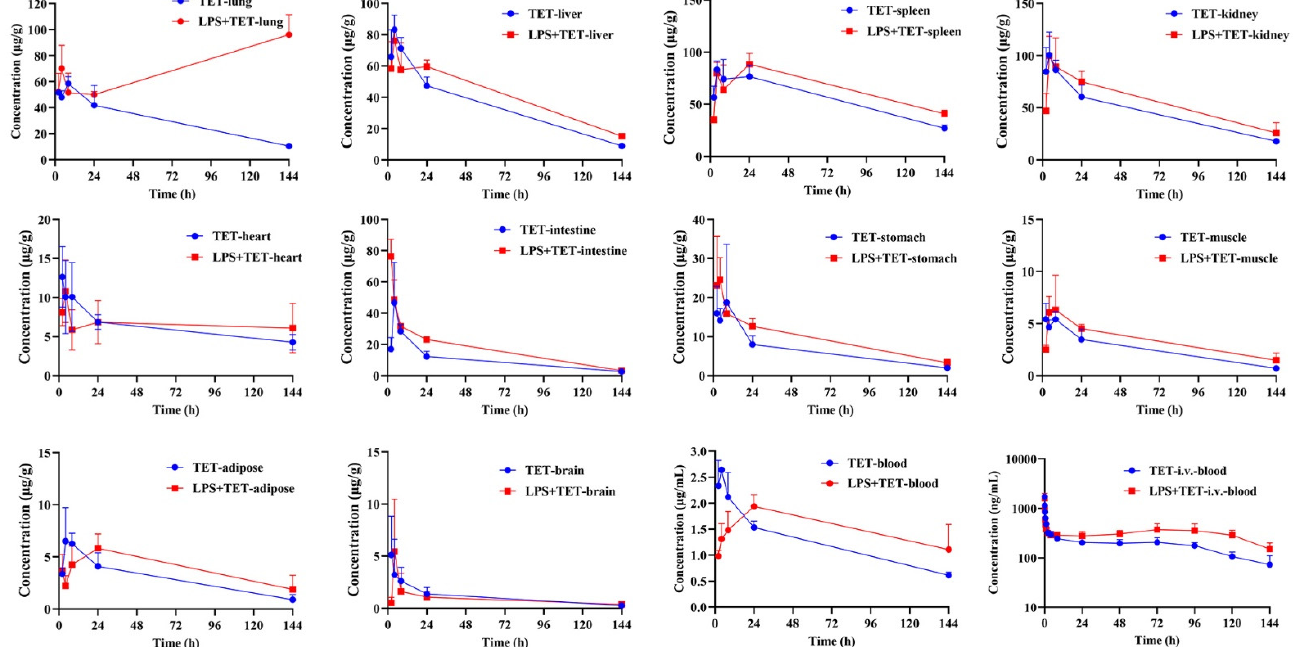
Int. J. Mol. Sci. 2022 , 23 , x FOR PEER REVIEW 5 of 17 Figure 2. Mean biodistribution versus time profiles of inhaled TET and blood concentration versus time curves via i.v. administration of TET in normal and LPS-induced ALI mice ( n = 3, Mean ± SD).